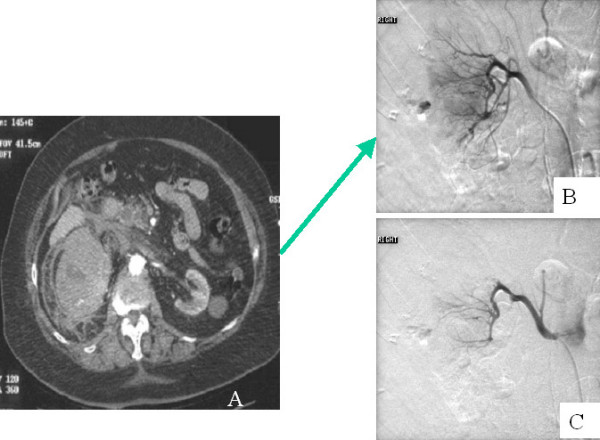
Spontaneous perirenal haemorrhage. A, Computerised tomography showing spontaneous perirenal haemorrhage. B, Angiography Pre-embolisation. C, Angiography Post-embolisation.